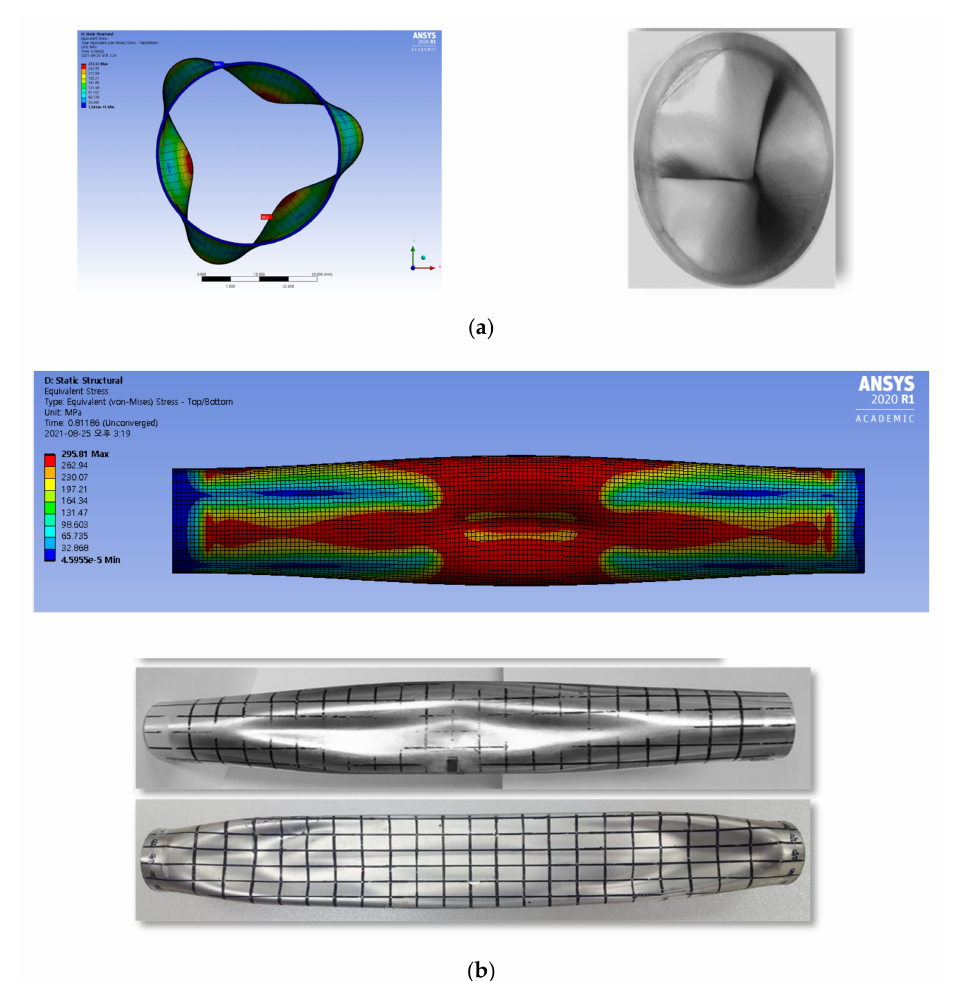
Figure 4. Examples of comparison of failure modes (reproduced from [19], with permission from Pukyong National University, 2022). ( a ) C1A, ( b ) C6D.